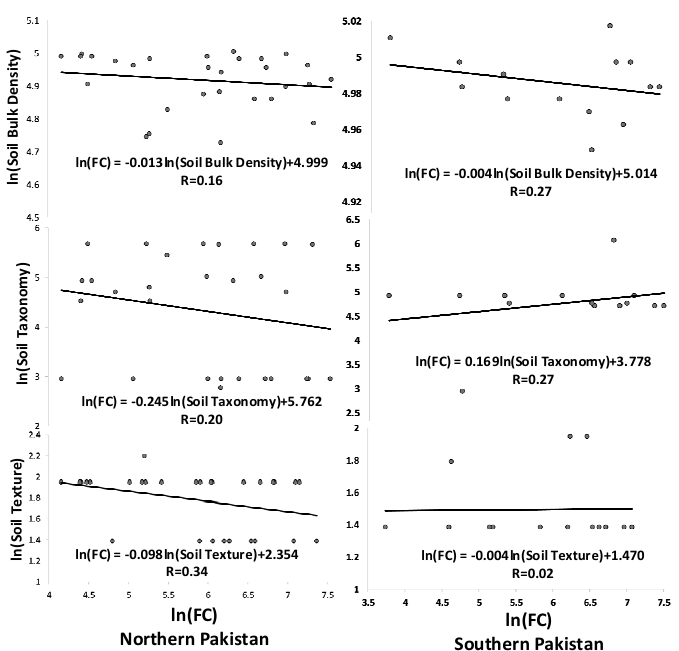
Figure 7. In Northern Pakistan (left panel) and Southern Pakistan (right panel), monthly FC (in logarithm) is plotted against mean (or mode of classes) soil properties (the right panel). The black lines indicate the linear least squares regressions.